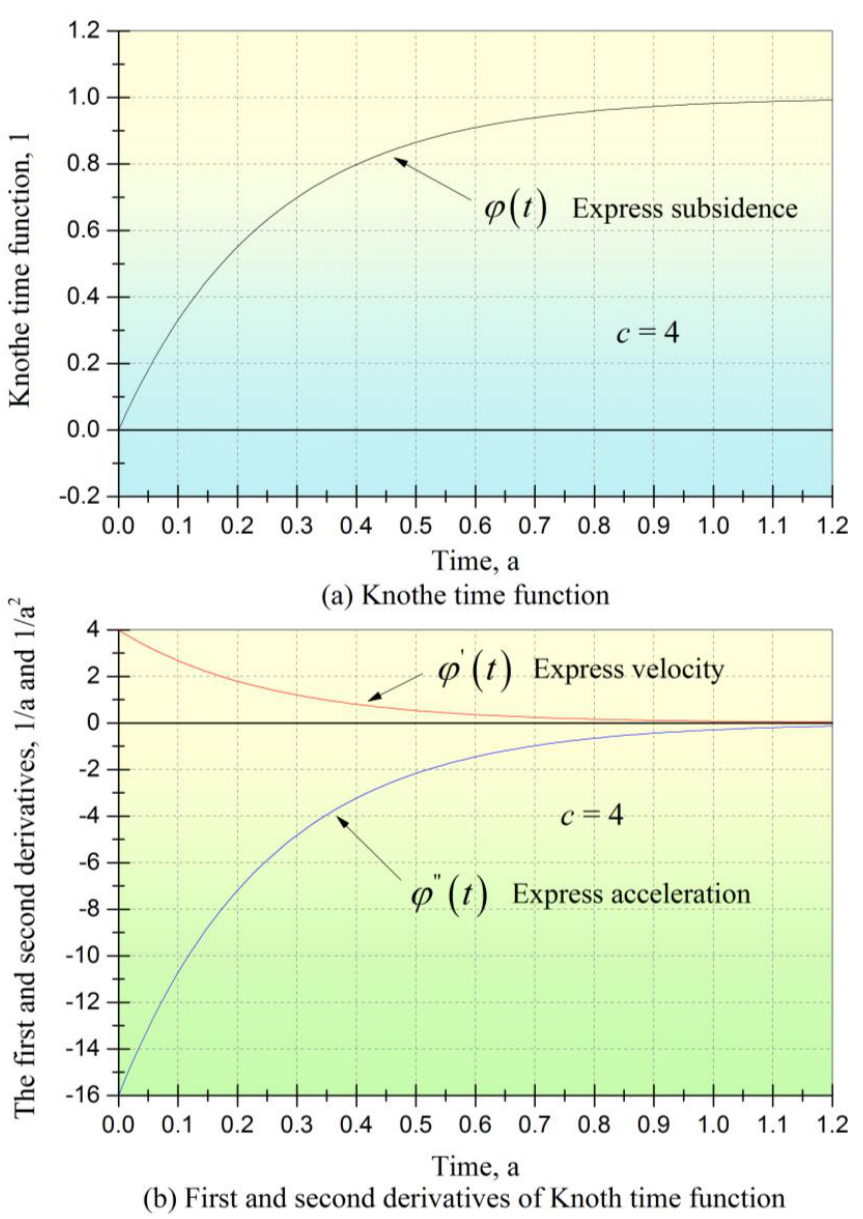
Figure 2. Knothe time function and its first and second derivatives. ( a ) Knothe time function; ( b ) First and second derivatives of Knoth time